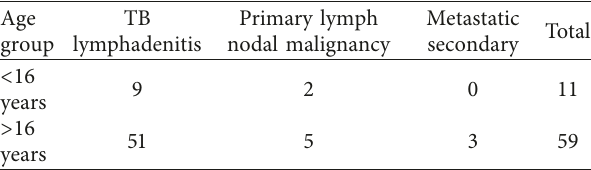
Table 2: Significant pathological yield.